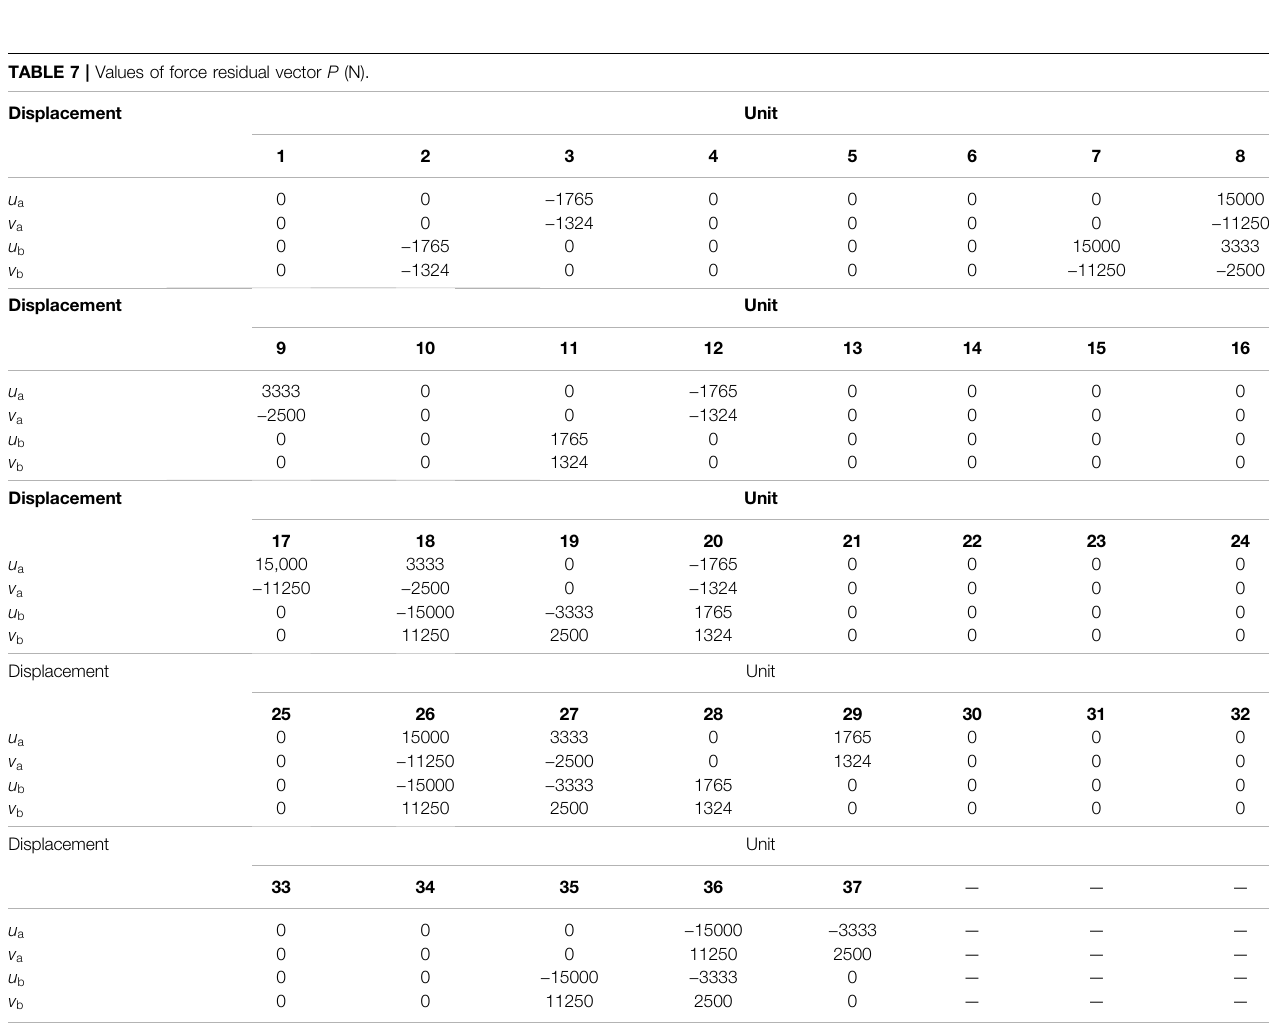
FIGURE 10 | Deformation diagram of truss.